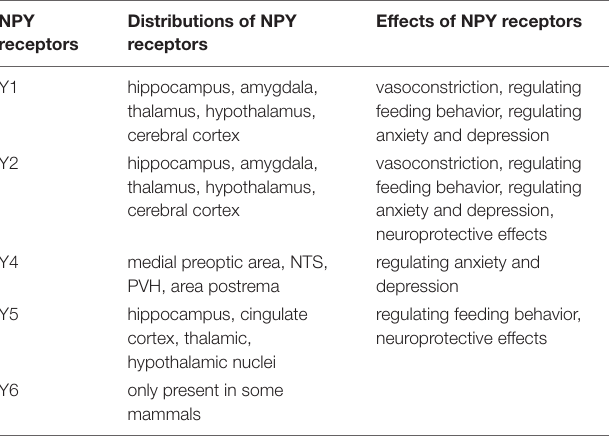
TABLE 1 | Distributions and effects of NPY in human